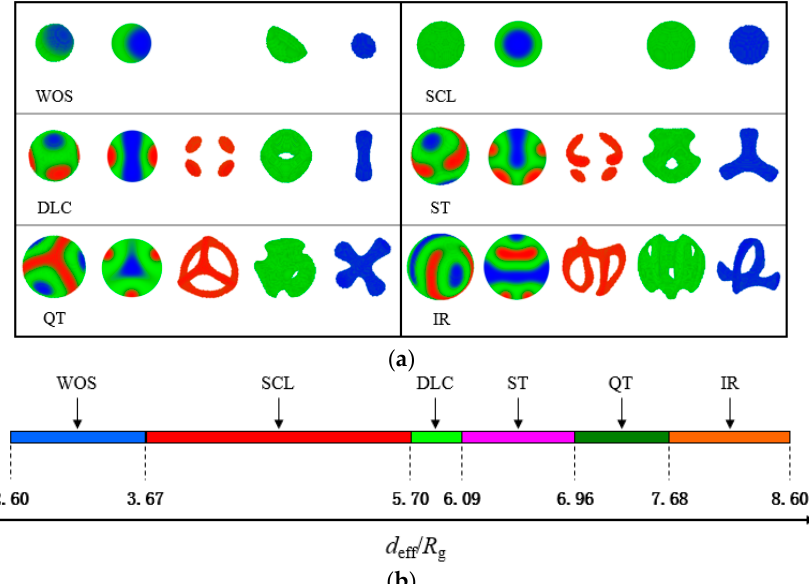
Figure 3. ( a ) Morphologies of the ABC linear triblock copolymers ( χ ij N = 35 and f A : f B : f C = 0.2:0.6:0.2) confined in a spherical cavity of various diameters ( d eff ranges from 2.60 R g to 8.60 R g ) with neutral surfaces. Red, green and blue represent the A-, B- and C-rich domains, correspondingly. ( b ) Phase stability regions as a function of effective diameter d eff .